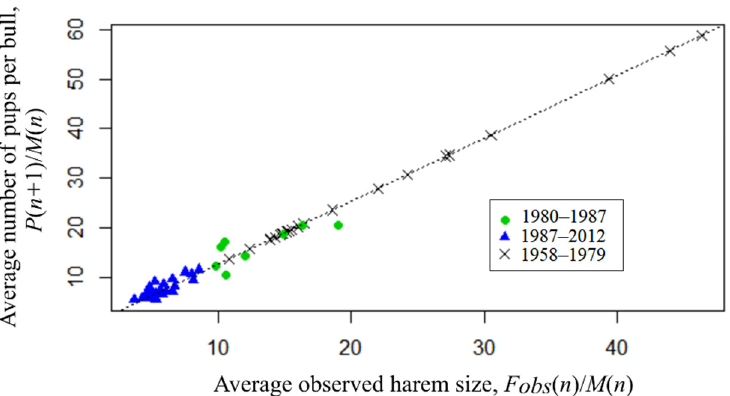
Figure 6. Average number of pups per bull ( P ( n + 1)/ M ( n ) dependence on average observed harem size ( F obs ( n )/ M ( n )) (theoretical values of tF obs ( n ) are used for the period 1958–1979).